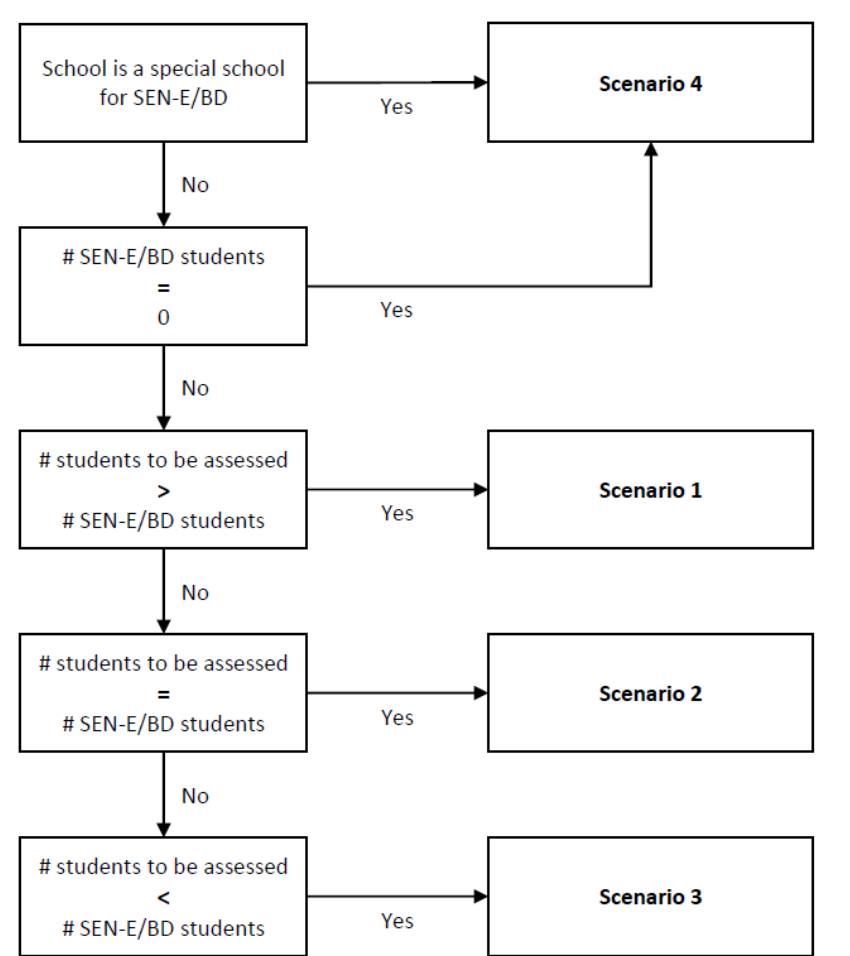
Figure 1. Path diagram to determine the correct scenario of the questionnaire.